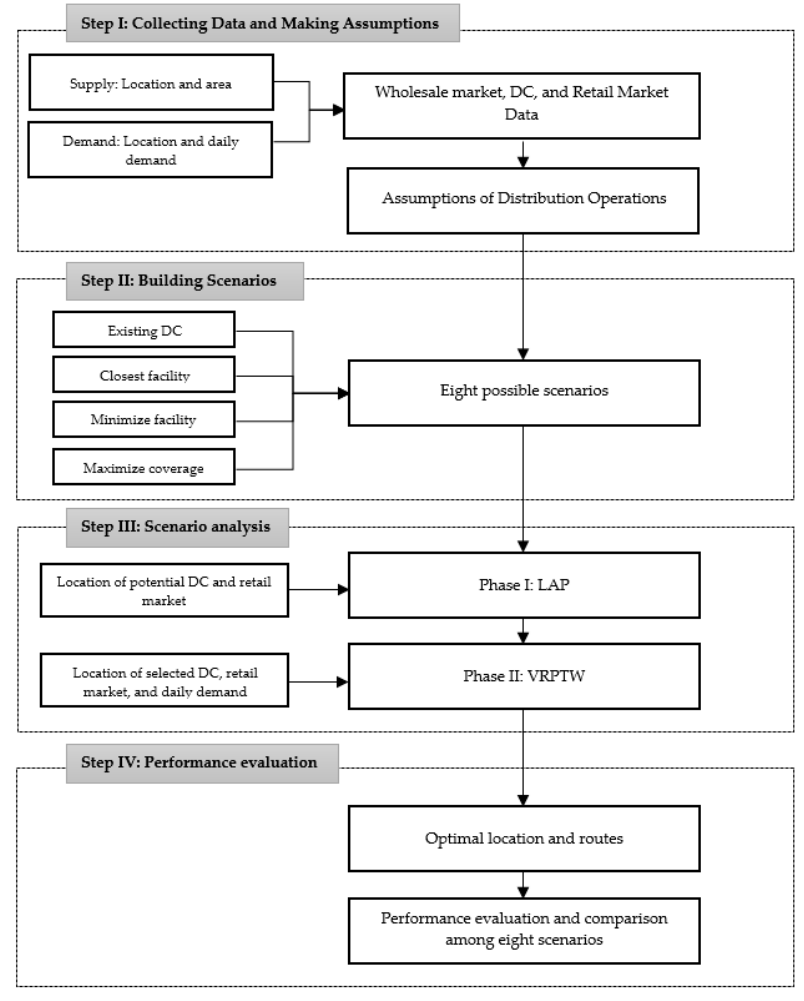
Figure 1. Main steps of the proposed methodology.